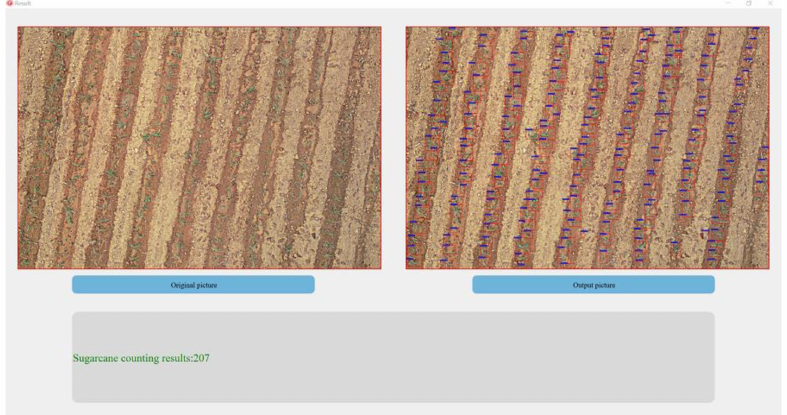
Figure 10. The software system’s graph of counting results with the original image displayed on the left, the detection results displayed on the right, and the number of cane seedlings displayed below.